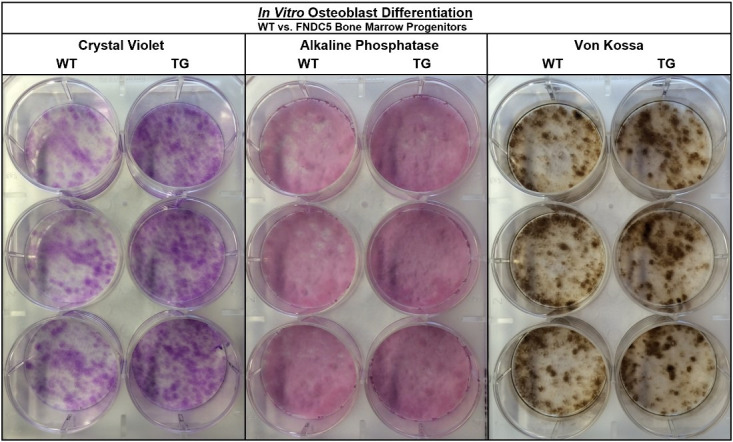
Representative images of in vitro osteoblast cultures from wild type (WT) or Fndc5-transgenic bone marrow progenitors after 18-day differentiation.Crystal violet and alkaline phosphatase staining for differentiation and von Kossa staining for mineralization show no qualitative difference between genotypes.